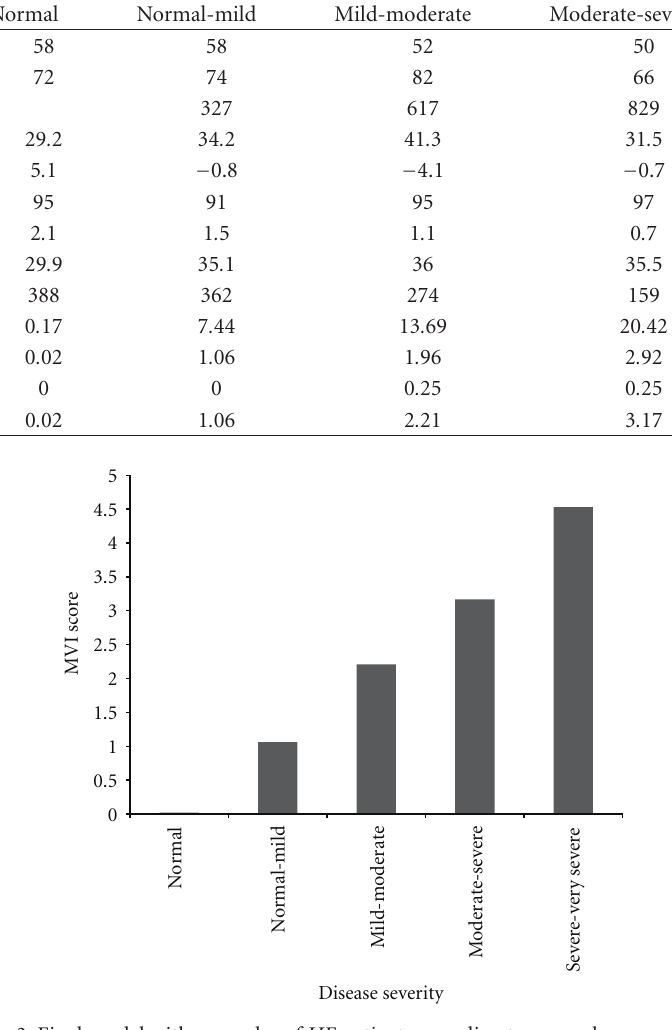
Figure 3: Final model with examples of HF patients according to gas exchange